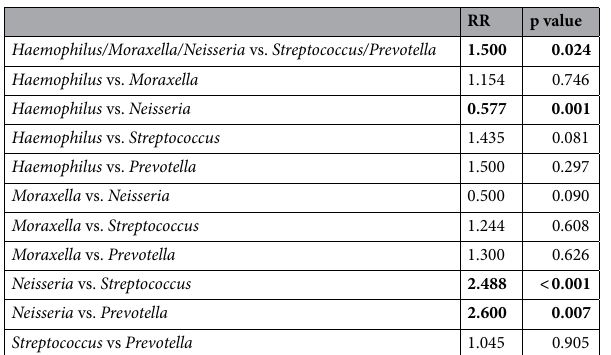
Table 2. Distinctly dominated sputum microbiota associate with risk of HIV-associated chronic lung disease. Values in bold were considered statistically significant at p ≤ 0.05.